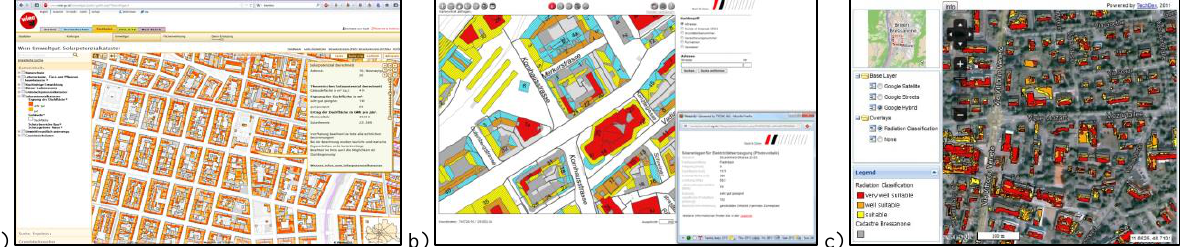
Figure 2: Examples of data representations by means of WebGIS for solar cadastres and photovoltaic potential of buildings: reclassified rasters of global solar irradiance overlaid to cadastral maps (Vienna – a), vector roof facets with assigned averaged values of incoming solar irradiance (St. Gallen – b), reclassified raster of PV potential overlaid on an orthoimage (Brixen –